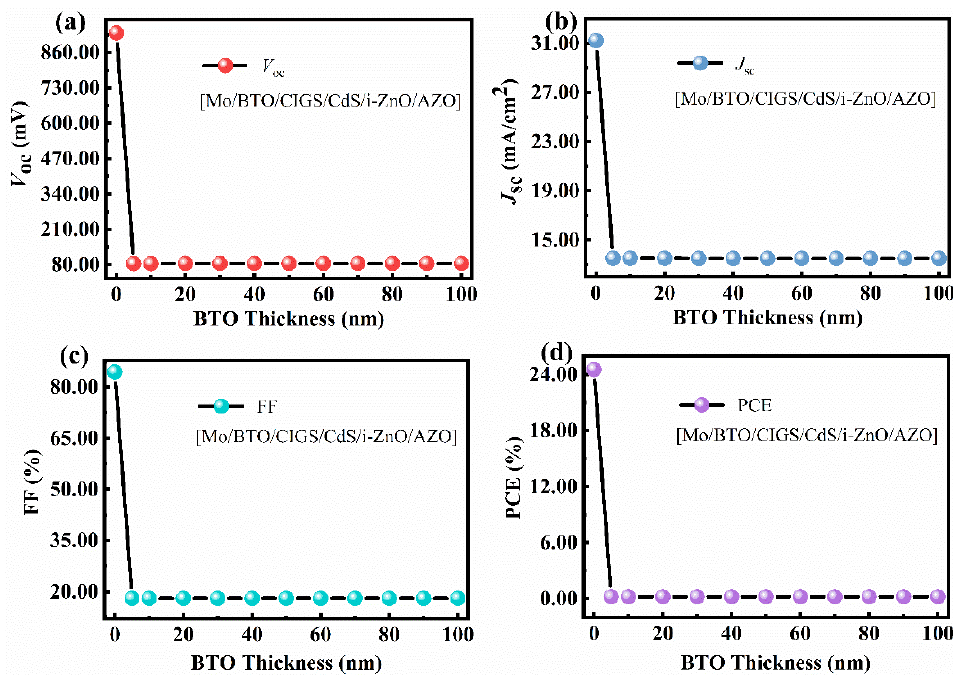
Figure 5. Dependence of ( a ) V oc , ( b ) J sc , ( c ) FF, and ( d ) PCE on the thickness of the BTO layer of the BTO-coupled CIGS solar cell with a device configuration of Mo/BTO/CIGS/CdS/i-ZnO/AZO.